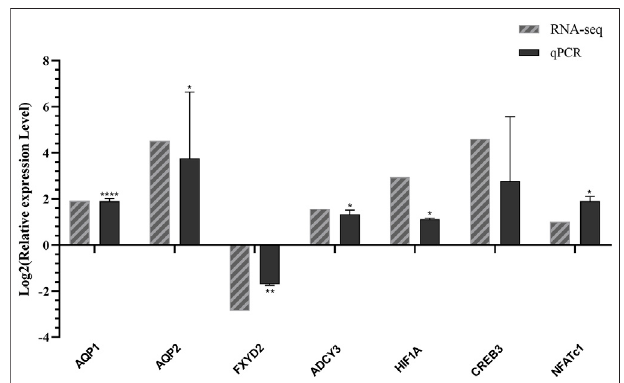
FIGURE 4 | Differentially expressed genes were identi fi ed by qPCR. RNA-seq: log 2 FoldChange number of unigenes L. yarkandensis:O. cuniculus in transcriptome data; qPCR: Log 2 value ofgene expression level relative to L. yarkandensis:O. cuniculus mRNA in RT-qPCR